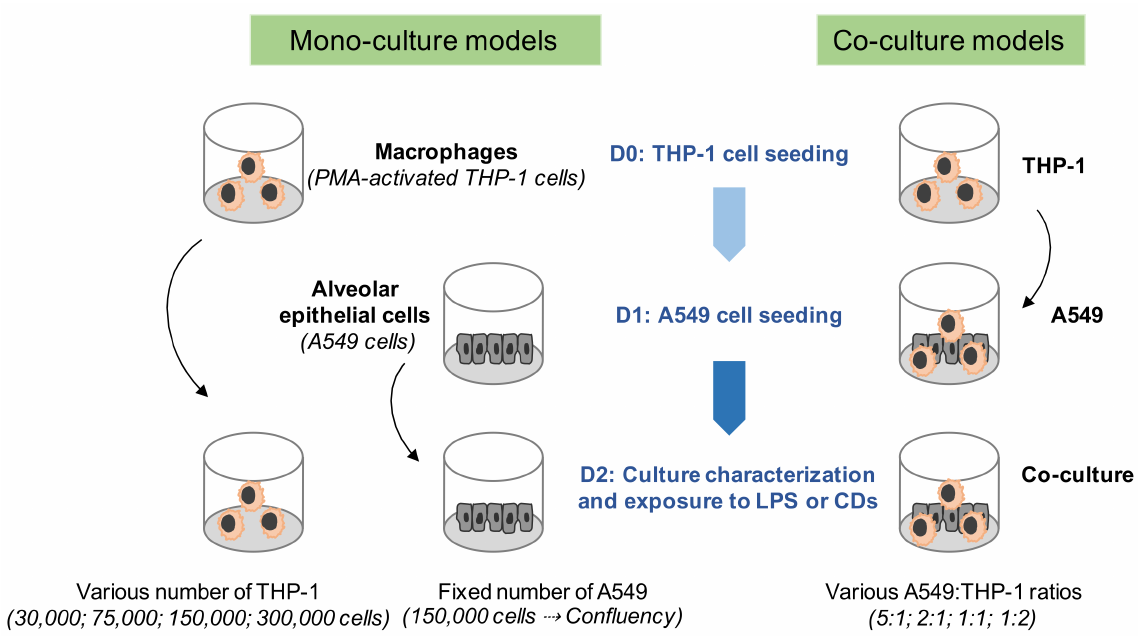
Figure 1. Schematic representation of the mono- and co-culture models used to assess the biological responses evoked by the